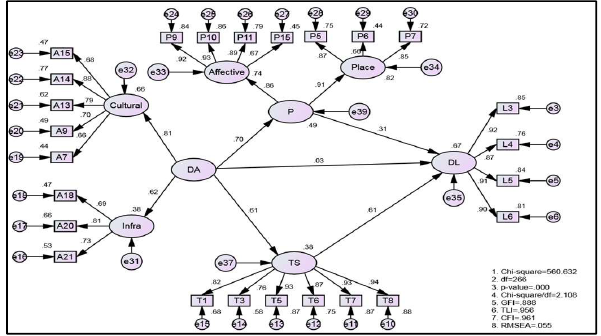
The Regression analysis